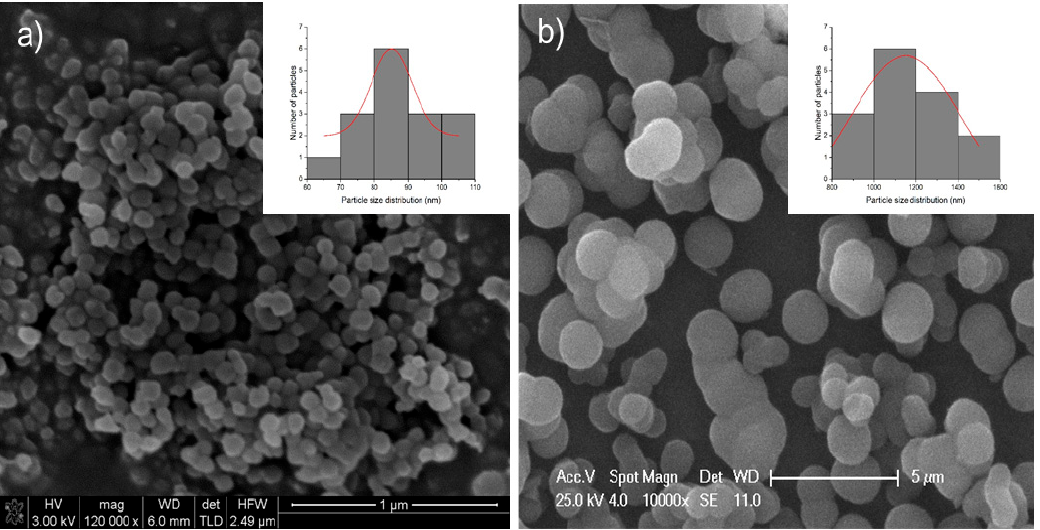
Figure 2. SEM images of ( a ) MSN and ( b ) MSU-2; insets represent the particle size distribution for each material calculated with ImageJ software.